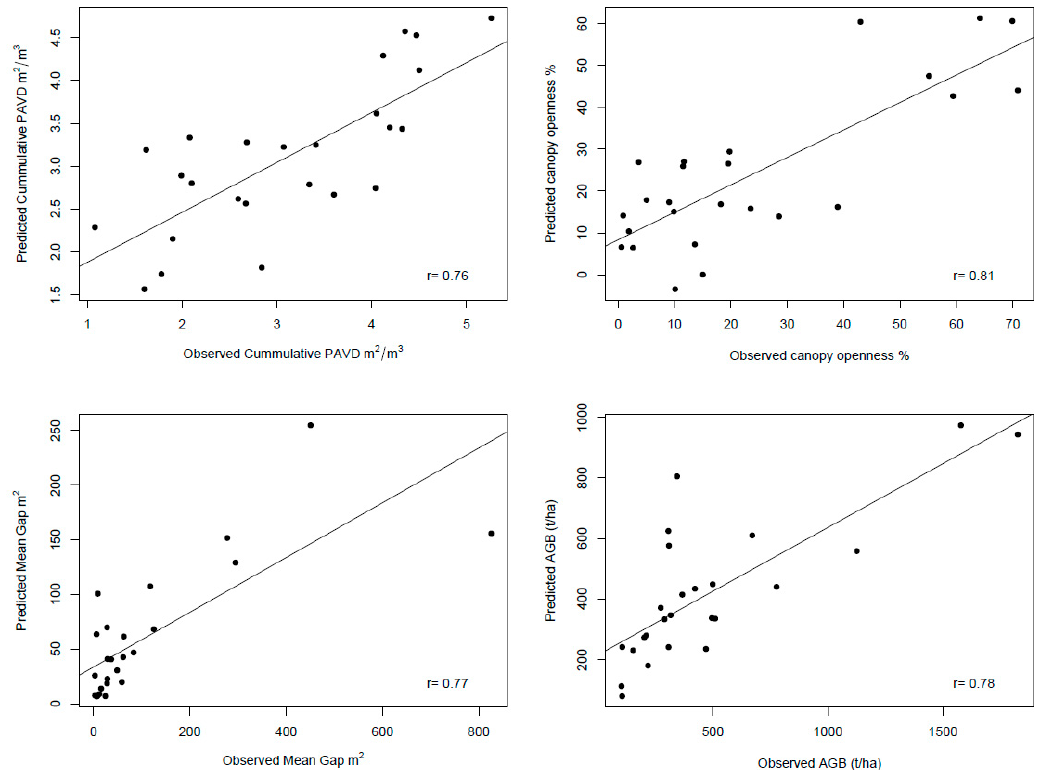
Figure 4. Relationship between field-measured (observed) and satellite remote sensing-predicted forest structure variables.